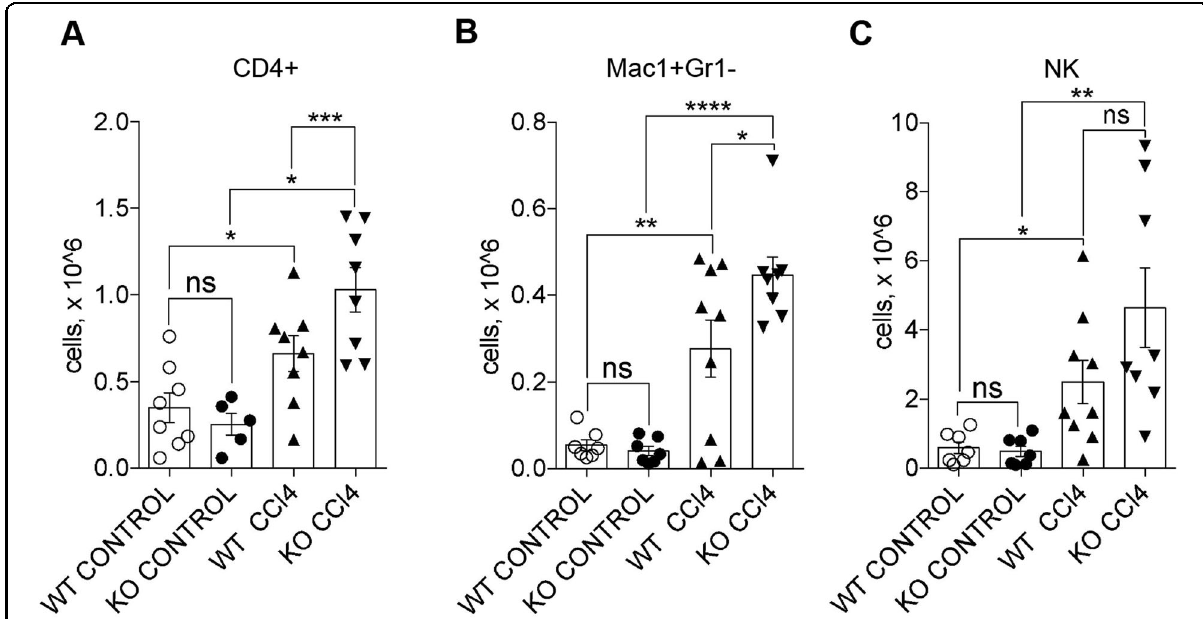
Fig. 4 Lack of GILZ results in increased monocyte, CD4 + T cell, and NK cell recruitment to the liver. A – C Number of CD4 + ( A ), Mac1 + Gr1 − ( B ), and NK ( C ) cells in fi ltrated in the livers of 4-month-old WT and GILZ KO mice that had been treated with oil (control) or CCl 4 for 72 h. Data were pooled from three independent experiments. Results are presented as the means ± SEM; each dot represents an individual mouse; scale bars indicate the mean (* p < 0.05, ** p < 0.005 *** p < 0.001, **** p < 0.0001, ns not signi fi